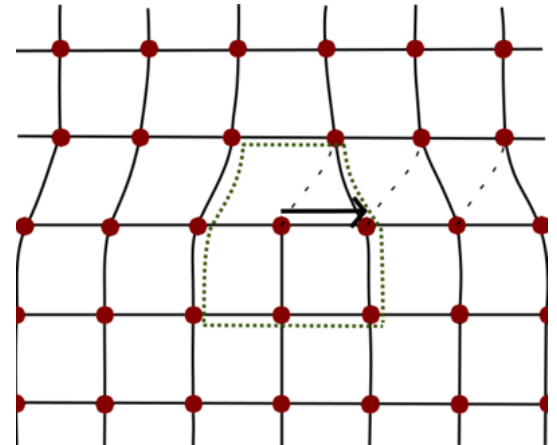
Figure 4: Illustration of an edge dislocation in a crystal. An extra column of atoms has been inserted in the lower half plane. The Burgers loop, indicated by the dotted green line, needs one extra hop below the dislocation core to close. The resulting Burgers vector points perpendicular to the column of inserted atoms